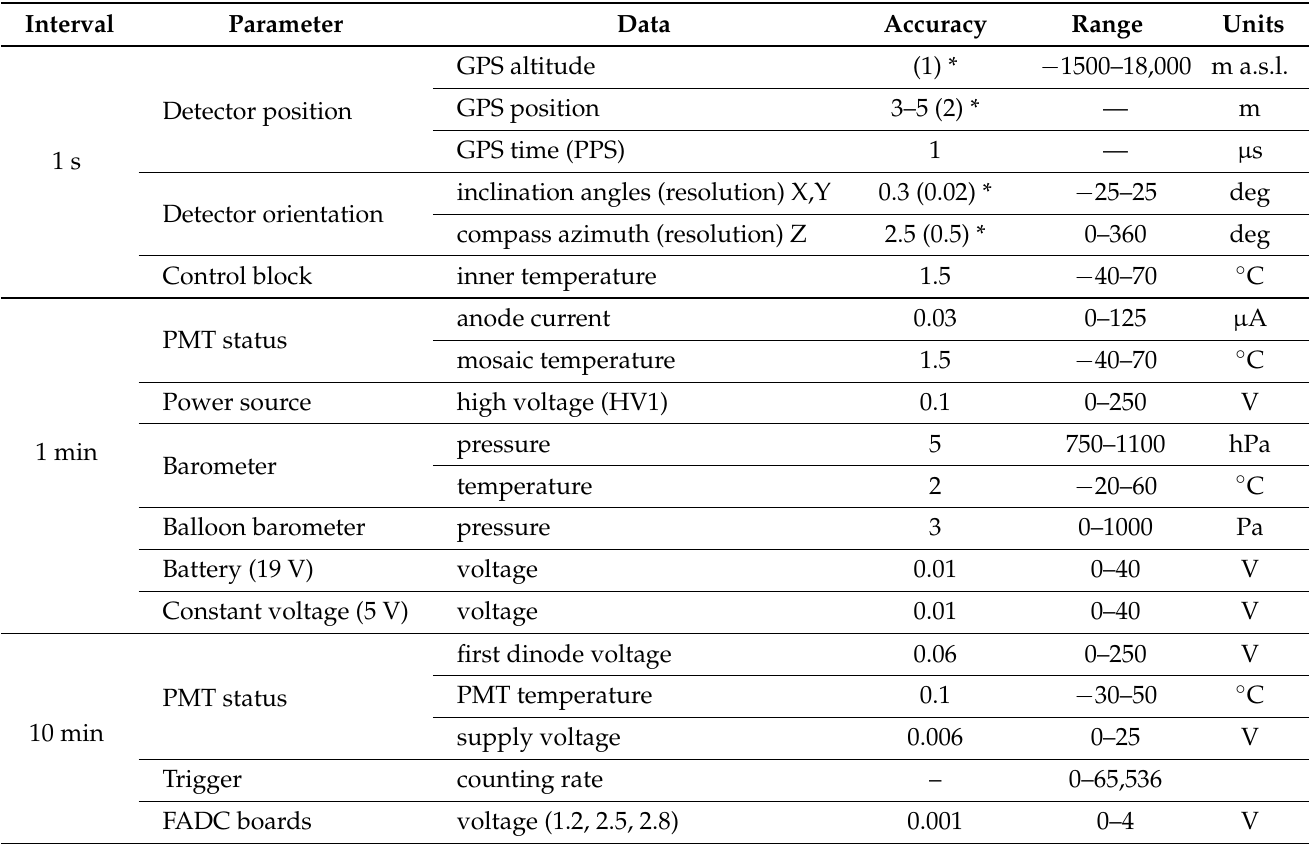
Table 2. SPHERE-2 telemetry data readout intervals and sensor